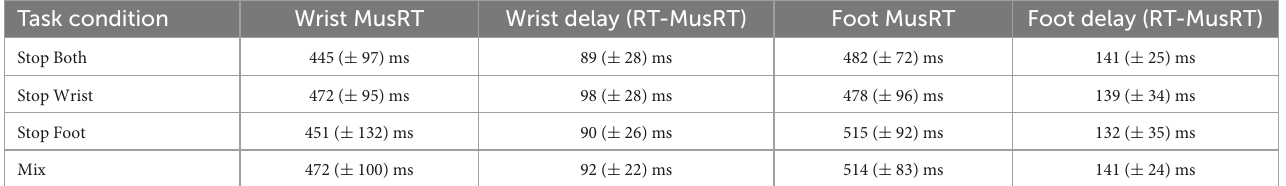
TABLE 1 Average delay (Mean and ± 1 SD) between muscle activation (MusRT) and onset of movement in No Stop trials reaction time (RT) and average MusRTs for wrist and foot movements. Task condition Wrist